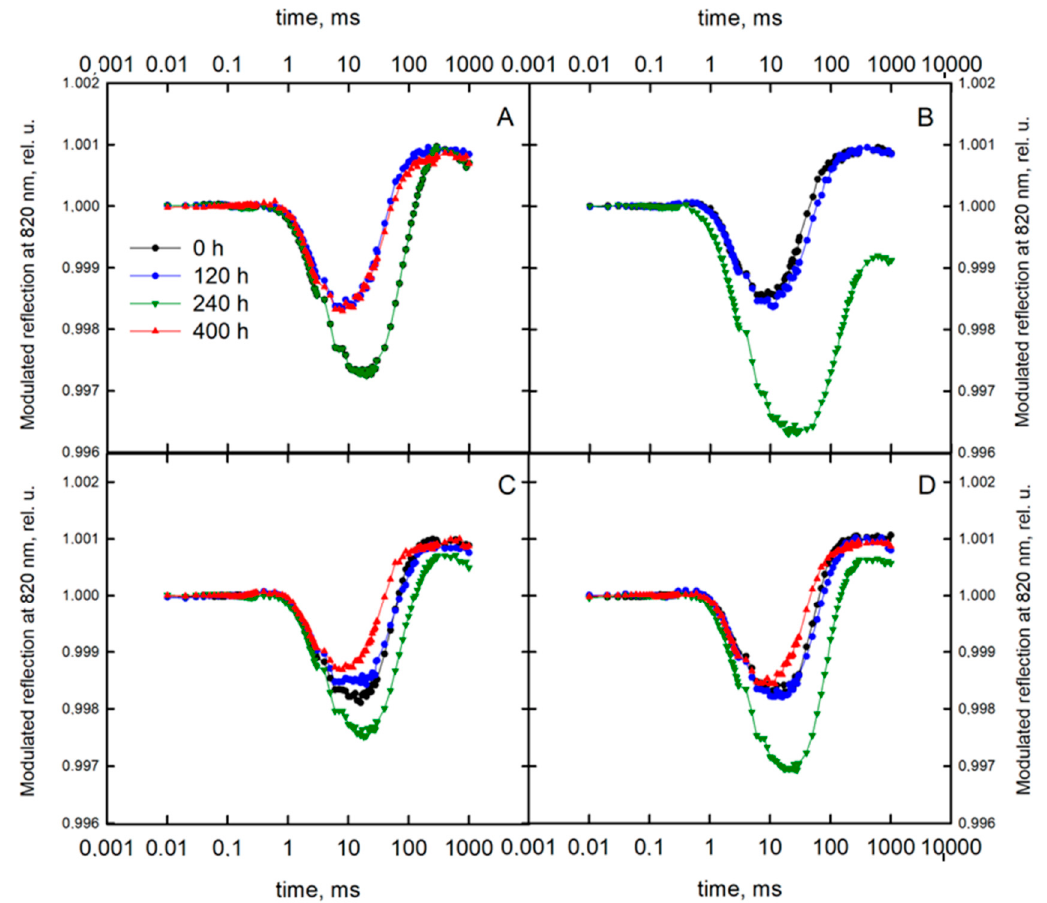
Figure 6. Kinetics of modulated light reflection at 820 nm (all data are normalized to the initial measured value of the signal) of perennial ryegrass varieties (Roadrunner and Nira) under different field water capacities of soil (50 and 30% FWC) and times (0, 120, 240, and 400 h after stress application): ( A ) Roadrunner under 50% FWC, ( B ) Roadrunner under 30% FWC, ( C ) Nira under 50% FWC, ( D ) Nira under 30% FWC. n = 6 relative units.